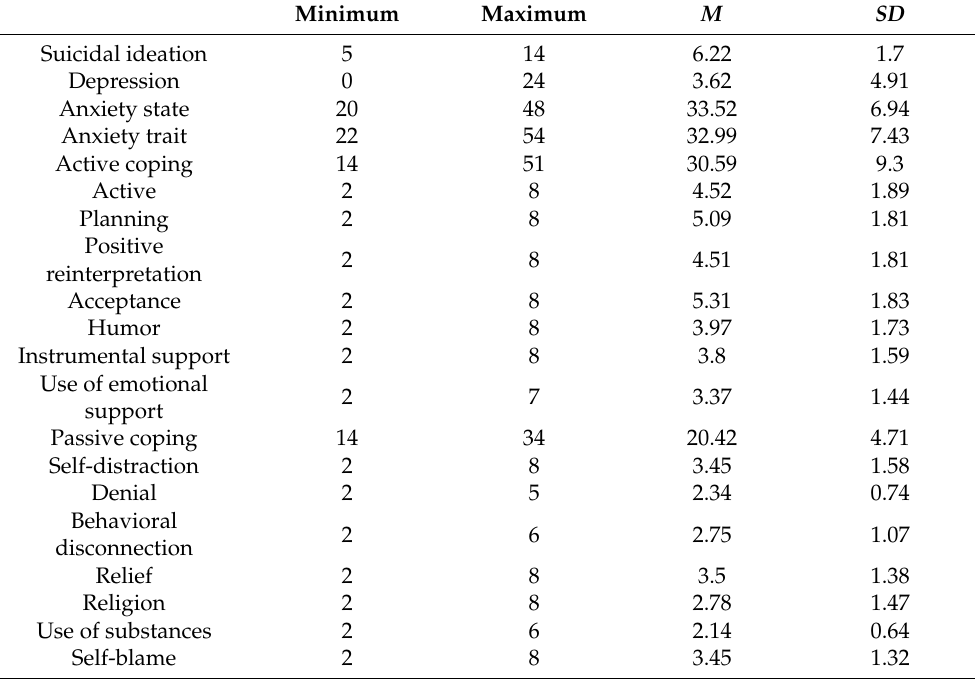
Table 1. Distribution of the sample scores.